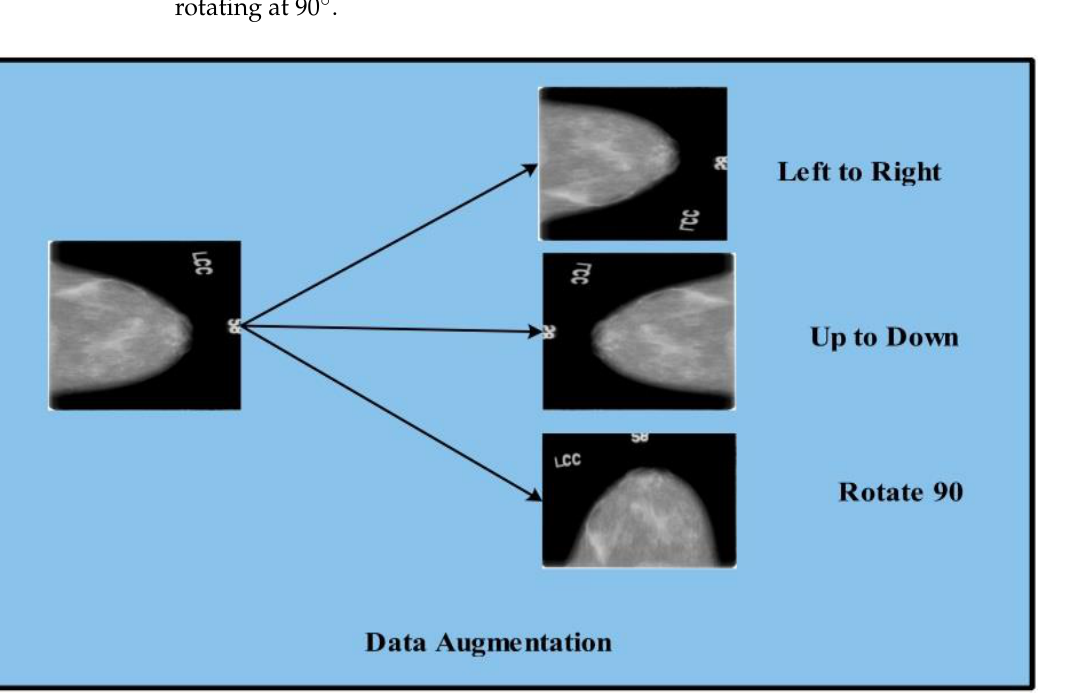
Table 1. Dataset information .